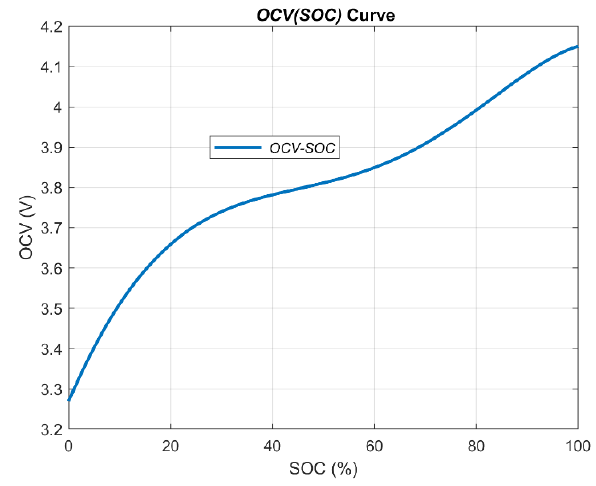
Figure 6. SOC-OCV Curve Plot.